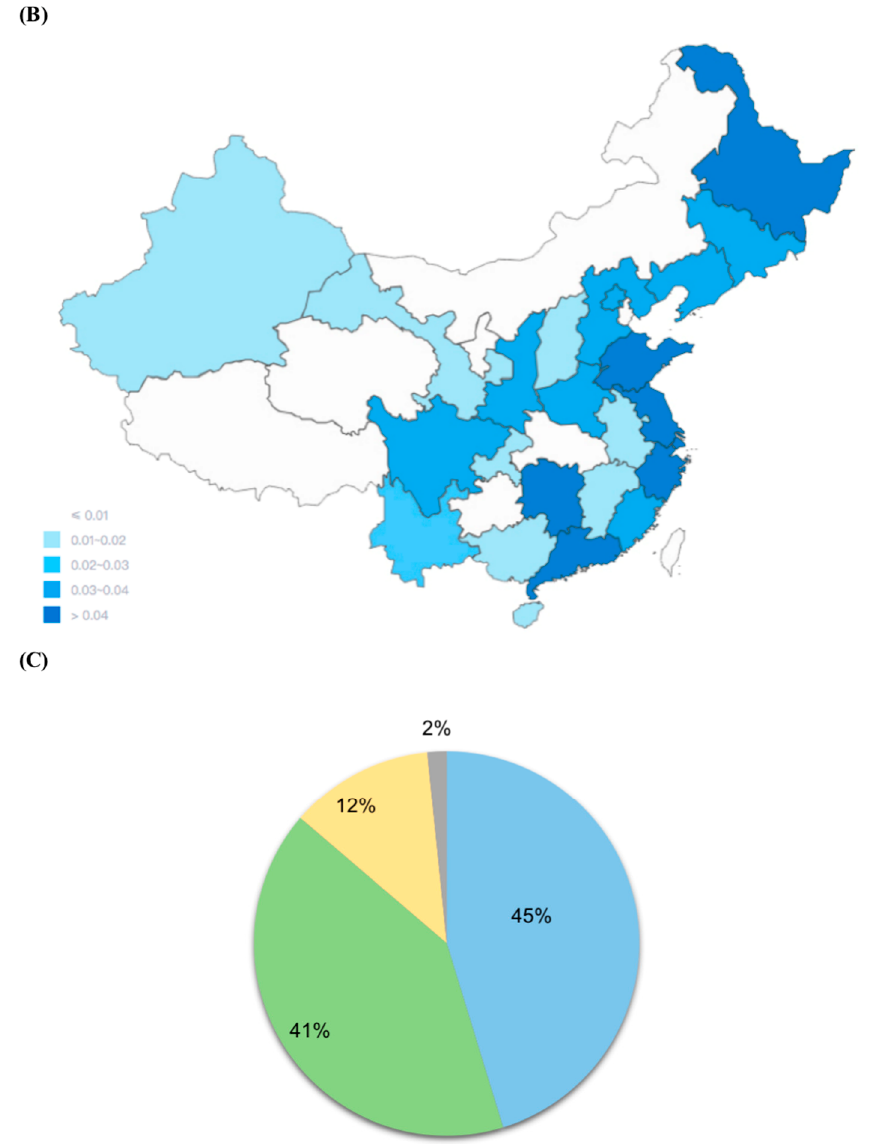
Figure 1. ( A ) The respondent hospitals covered 28 provinces in China; ( B ) number of hospitals sampled from each province; and ( C ) the level of the cities involved in this study.